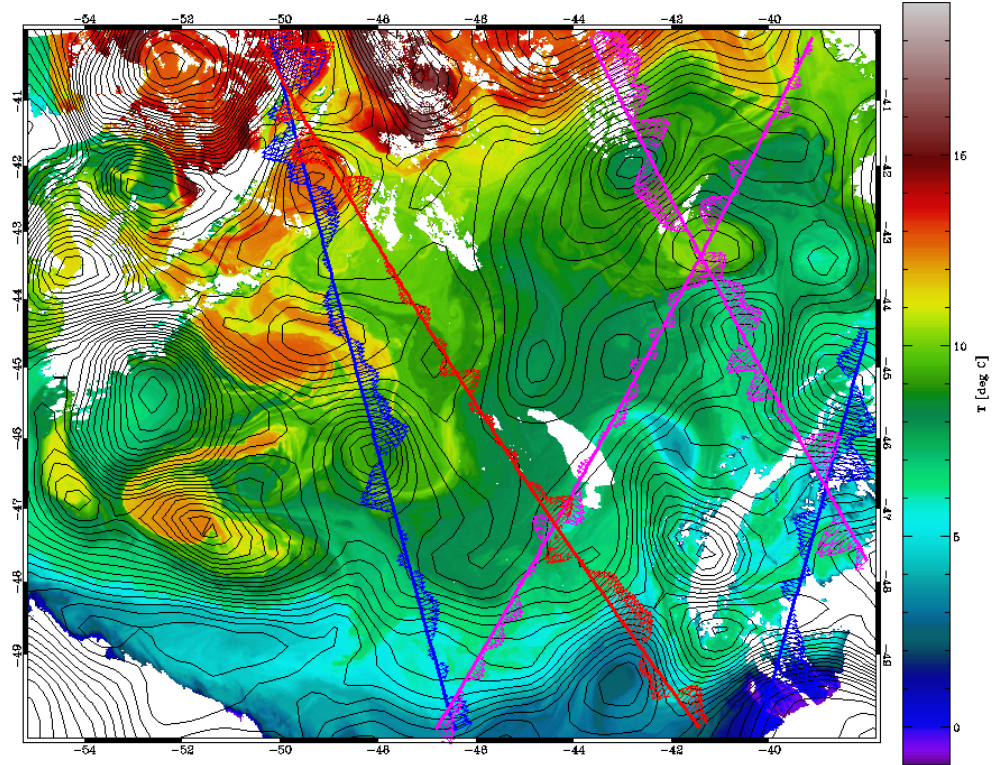
Figure 4. Sea surface temperature from MODIS Aqua with sea surface height from AVISO (black lines) obtained from the combination of measurements provided by different altimeters. Lines show the available measurements in the period of ± 12h around the time the image was taken provided by Jason-1 (red), Envisat (blue) and GFO (purple). Arrows correspond to the cross-track geostrophic